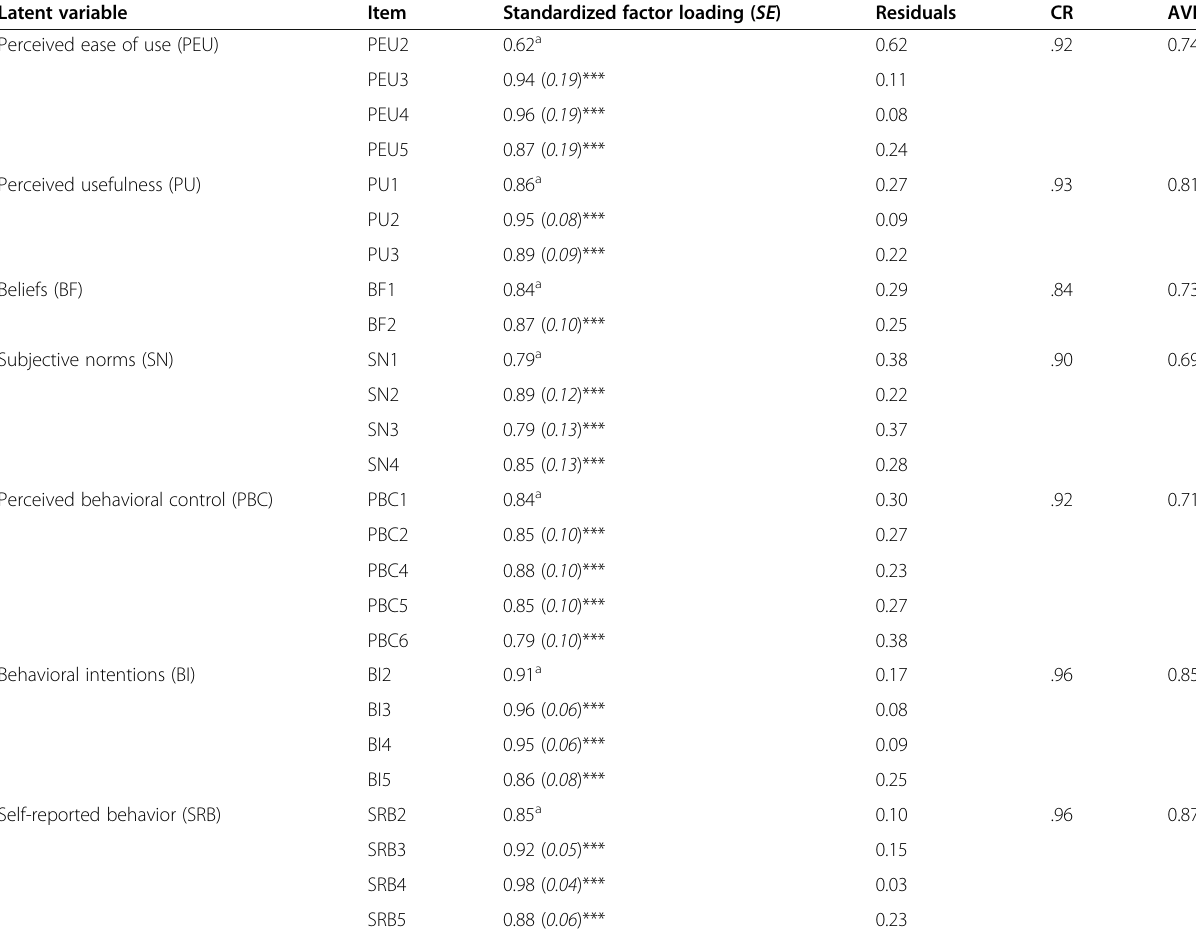
Table 3 Statistics for the latent variables Latent